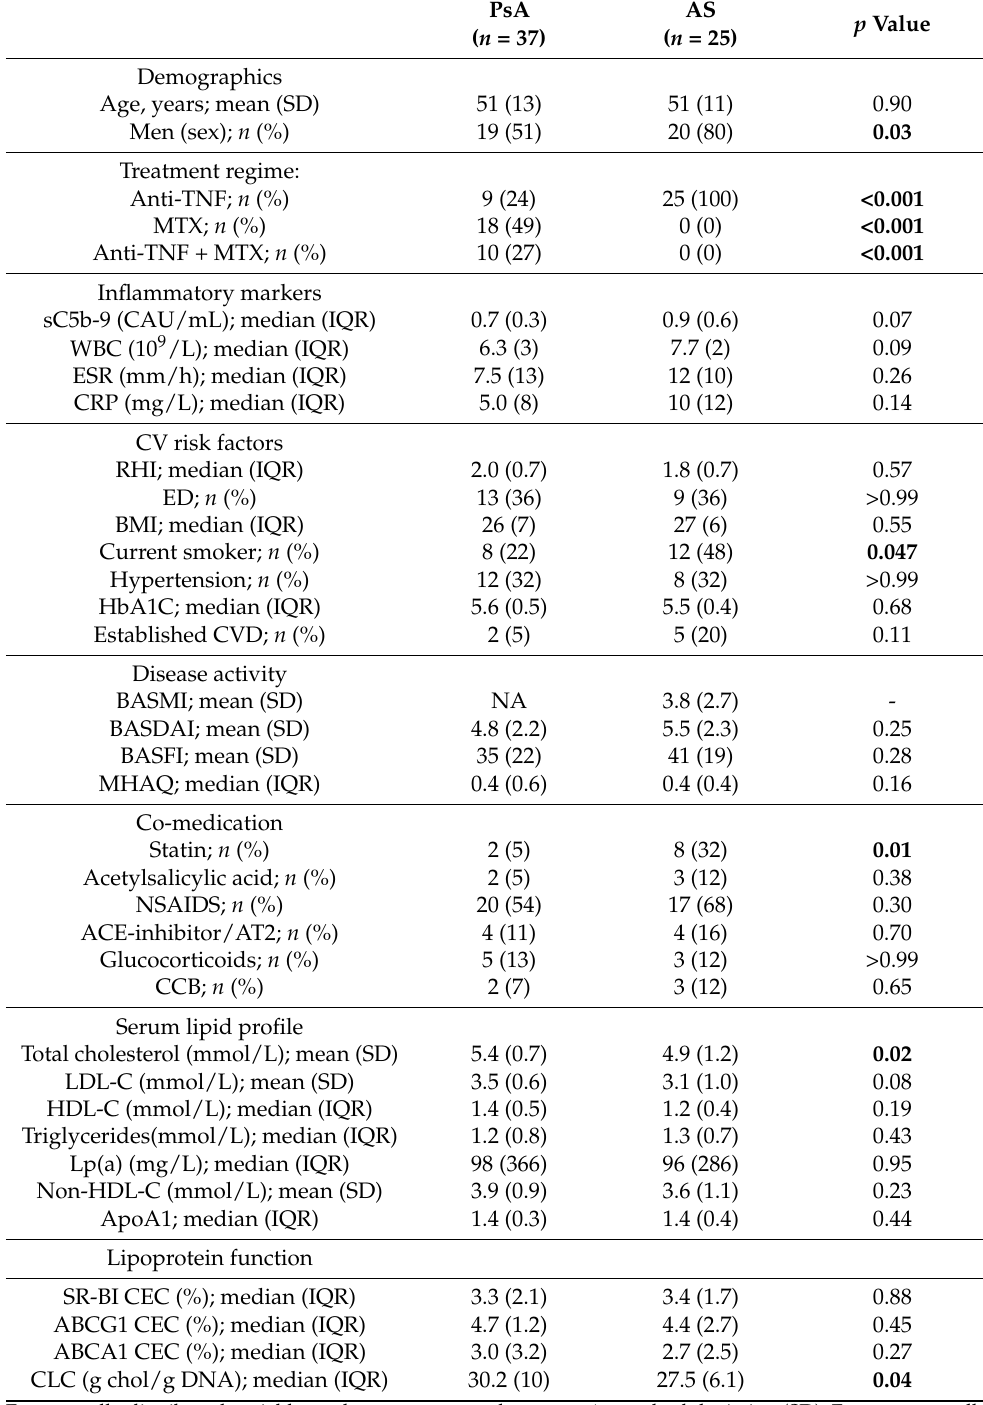
Table 1. Baseline characteristics of the two patient